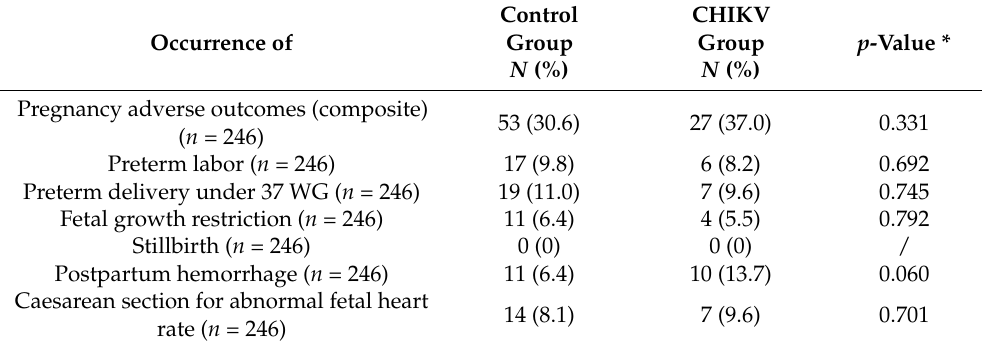
Table 3. Frequency and comparison of pregnancy outcomes during pregnancy and delivery (pregCHIKV study N =246).